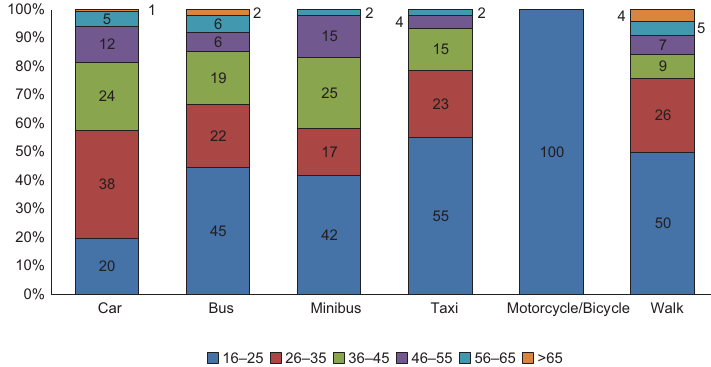
Fig. 12. Types of transportation used by people of different age